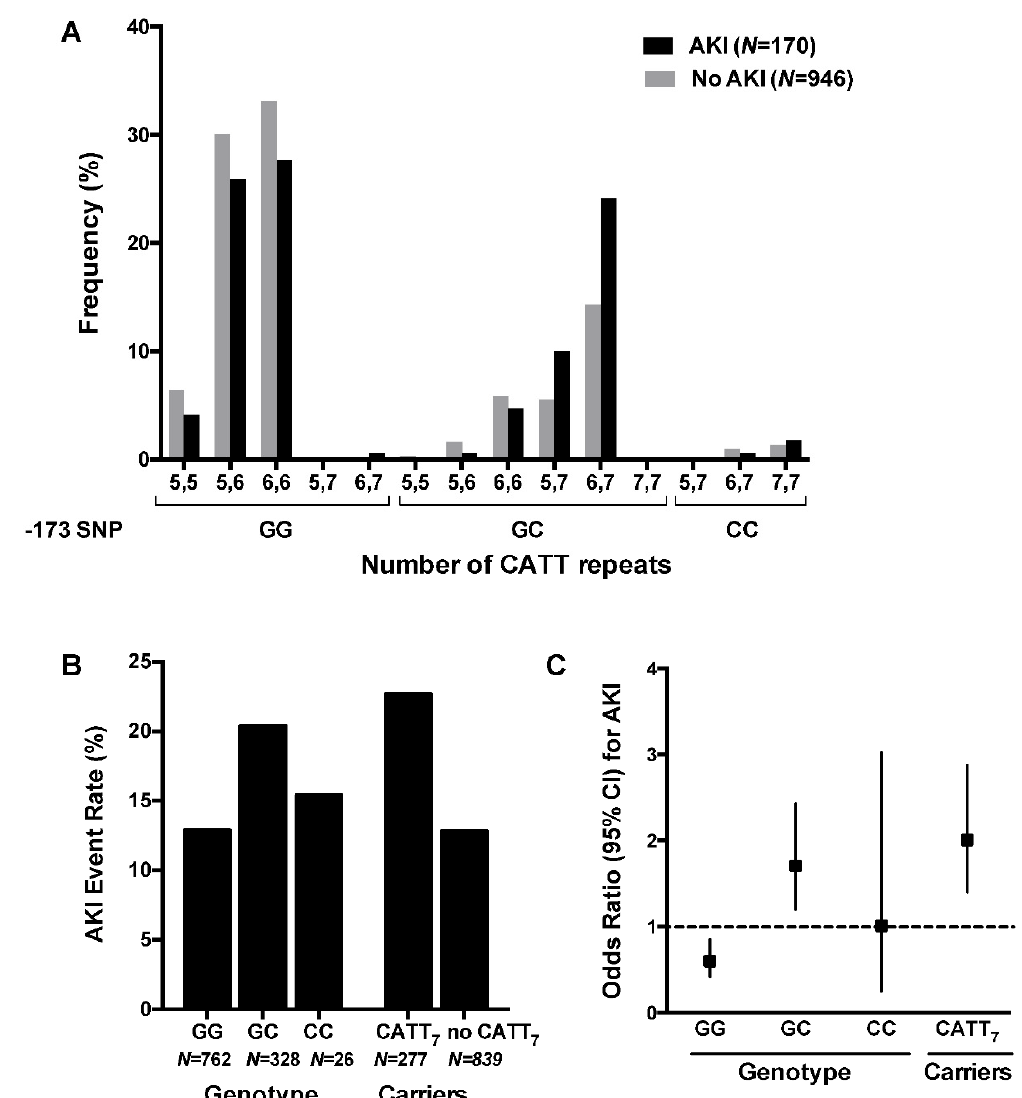
Figure 1. Frequency distribution of the CATT microsatellite repeat (rs3063368) and the G > C SNP (rs755622) in patients with AKI versus patients not affected by AKI after cardiac surgery. ( A ) In patients with AKI, the frequency of the GC genotype and the CATT 7 allele is higher than in patients without AKI ( X 2 test for trend, p = 0.001). ( B ) The AKI event rate was higher in patients with the GC genotype (20%) versus patients with the CC or the GG genotype (13%), and higher in CATT 7 carriers (23%) compared to non-carriers. ( C ) Patients carrying the GC genotype or the CATT 7 allele had a significantly increased relative risk of AKI compared to all other patients.